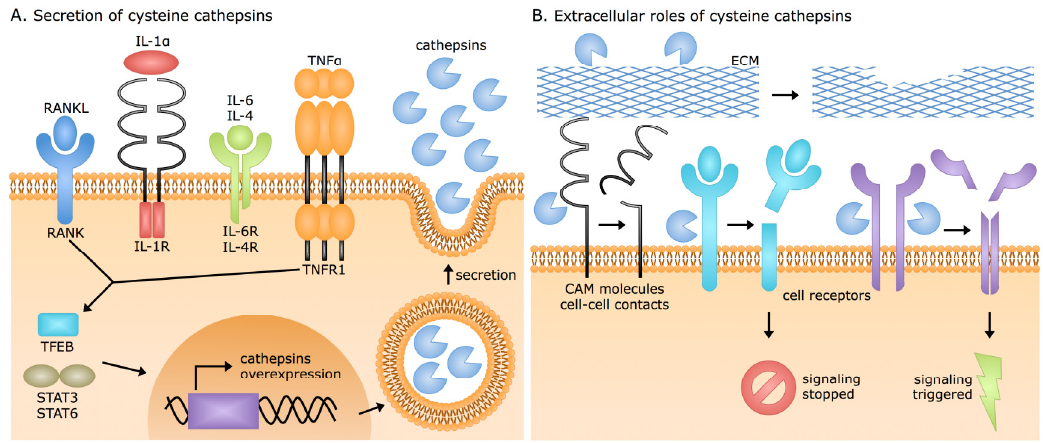
Figure 2: Cysteine cathepsin secretion and their extracellular roles. ( A ) Secretion of extracellular cathepsin is often tightly connected with their overexpression and can be triggered by diverse cell signaling pathways. Overexpressed cysteine cathepsins are usually secreted with vesicular exocytosis. ( B ) In the extracellular milieu, cysteine cathepsins cleave different targets. Cleavages of cell adhesion molecules (CAM), cell-cell contacts, and proteins of ECM mainly influence cell adhesion and migration. Additionally, proteolytic products of these cleavages can act as signaling molecules and have an impact on cell growth, invasion, and angiogenesis. Other main target of cysteine cathepsins are cell receptors, and their cleavage can result in either constantly triggered signaling, in the case of partial trimming of the receptor, or inhibited signaling, in the case of a complete removal of the extracellular domain. CAM, cell adhesion molecules; ECM, extracellular matrix; IL, interleukin; RANK, receptor activator of NF-κΒ; RANKL, receptor activator of NF-κΒ ligand; STAT, signal transducer and activator of transcription; TFEB, transcription factor EB; TNFα, tumor necrosis factor alpha; TNFR1, tumor necrosis factor receptor 1.